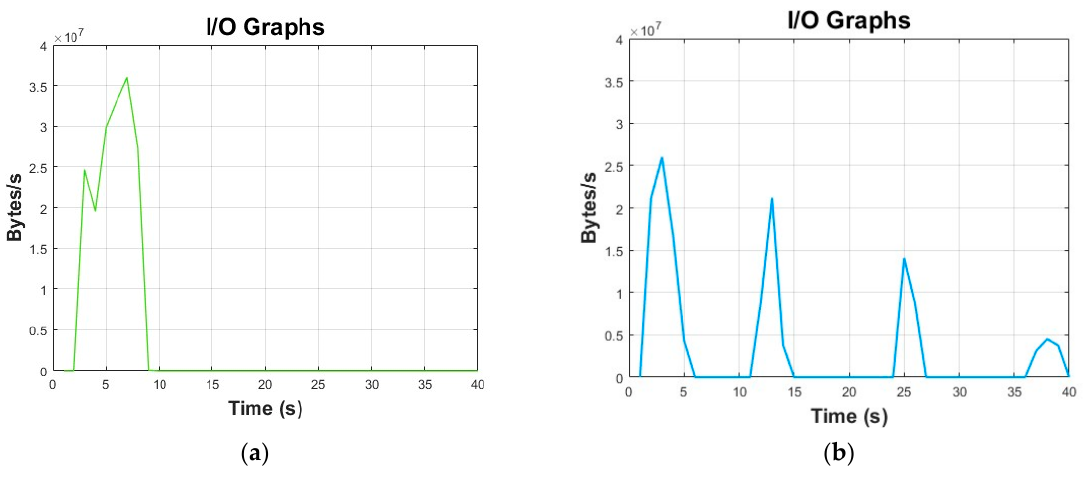
Figure 9. Network traffic I/O graph: ( a ) conventional method; ( b ) proposed method.